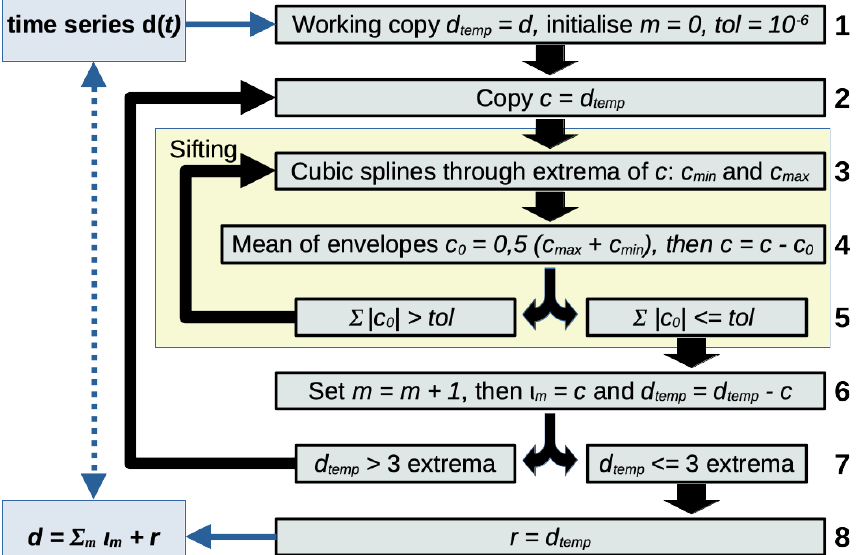
Figure 1. Basic Empirical Mode Decomposition. Note that the sifting stop criteria (point 5) above is given in its original form and various alternatives have been discussed in the literature [27]. However, the exact formulation of the stopping criteria for the sifting process (points 3 to 5) is not central to our work as the EMD algorithm performs with any chosen